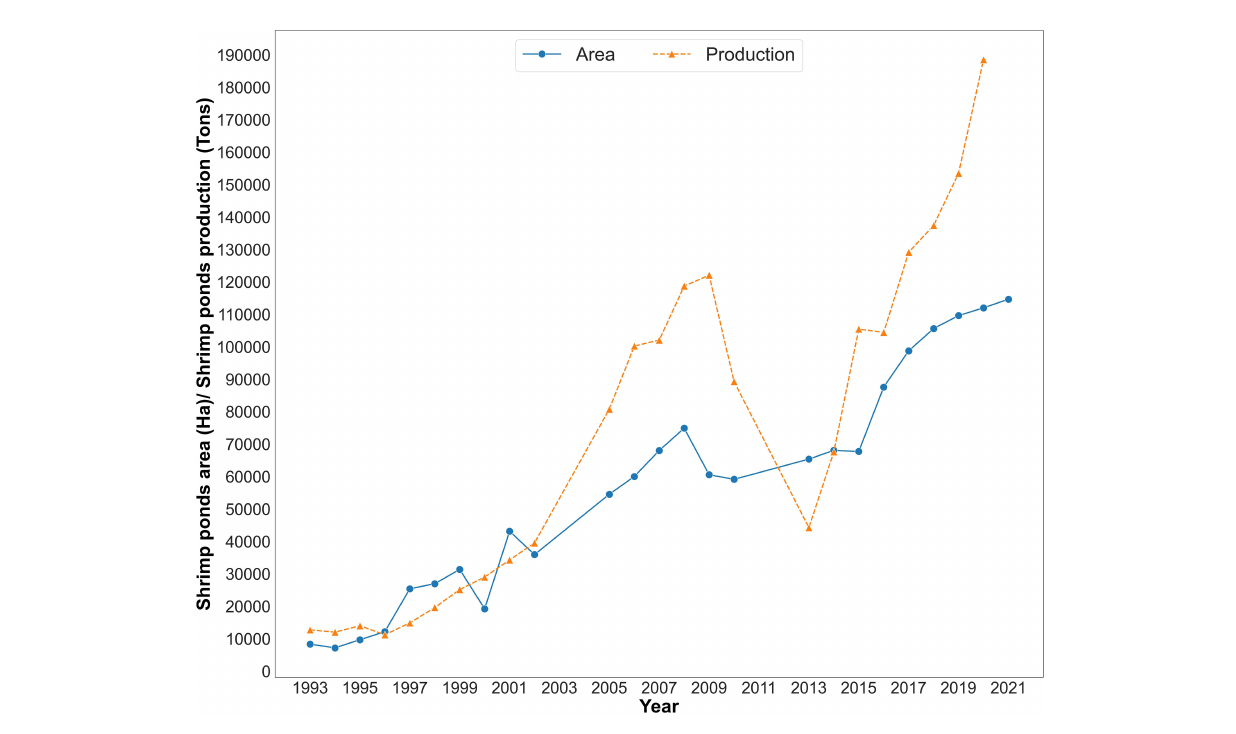
FIGURE 1 Total estimated area of shrimp ponds (ha, blue line) based on remote sensing and shrimp production (tons, dotted orange line) from 1993 to 2021, for the east part of the Gulf of California corresponding to the Mexican states of Sinaloa and